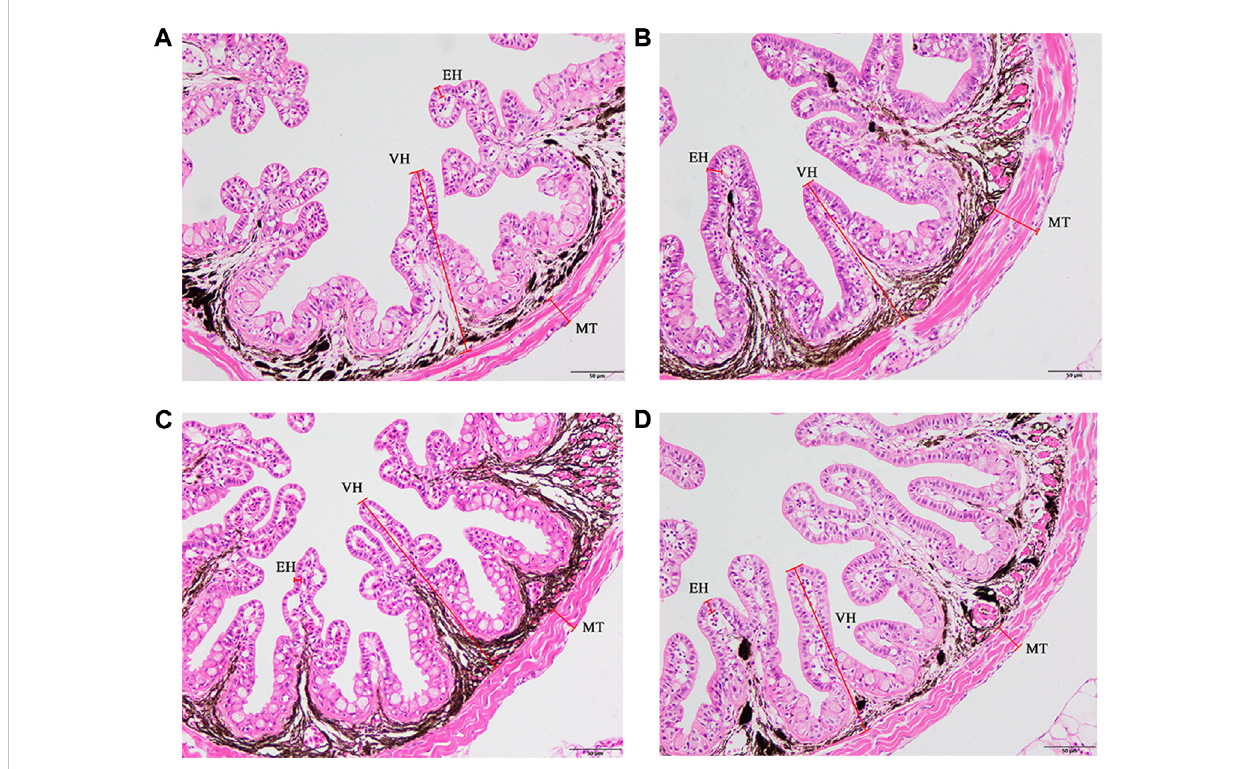
FIGURE 2 Effects of supplemental fulvic acid on intestinal morphology oflarge yellow croaker larvae. Control group (0.00%) (A) ;0.01% FA group (B) ;0.02% FA group (C) ; 0.04% FA group (D) . MT, muscular thickness; VH, villus height; EH, enterocyte height (HE staining; Scale bar = 50 μ m).